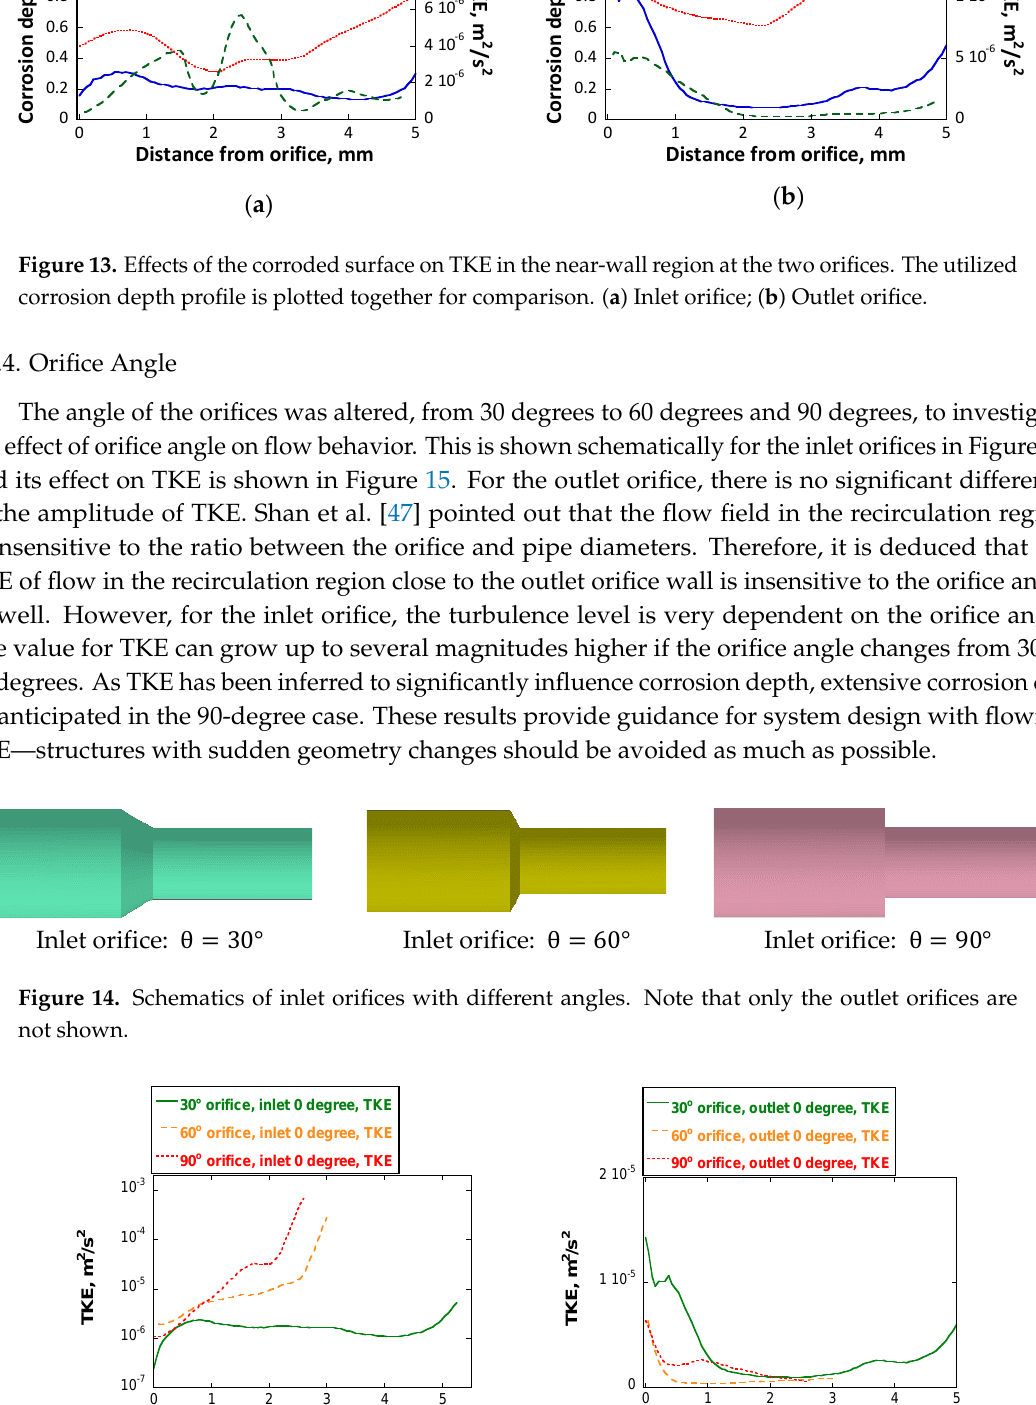
Figure 15. Effects of orifice angle on TKE in the near-wall region for the two orifices. ( a ) Inlet orifice; ( b ) Outlet orifice.